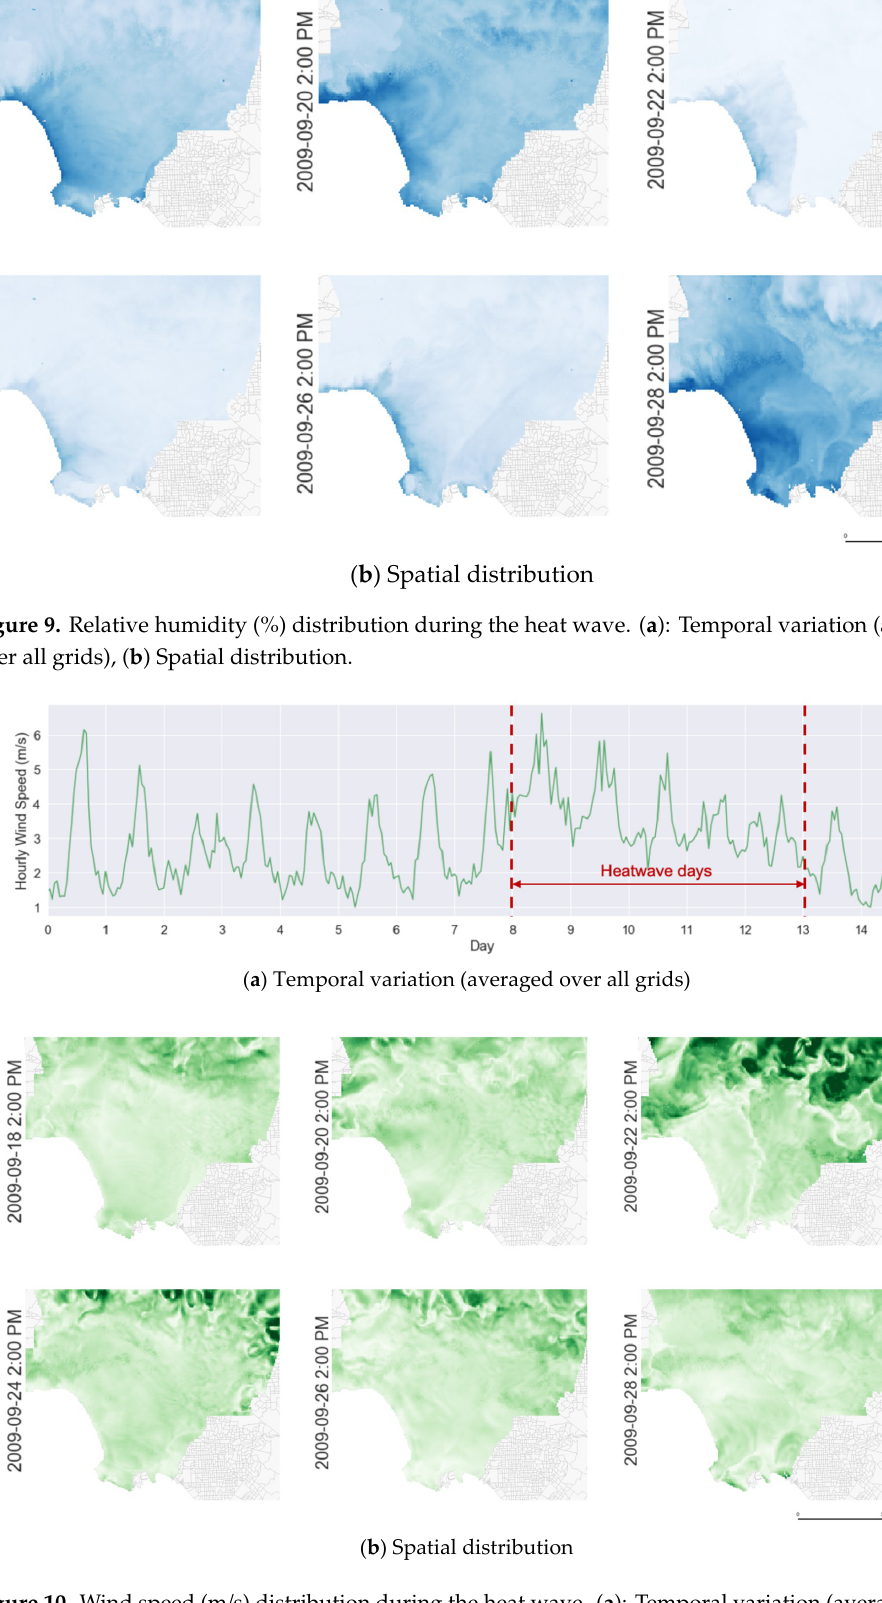
Figure 10. Wind speed (m / s) distribution during the heat wave. ( a ): Temporal variation (averaged over all grids), ( b ) Spatial